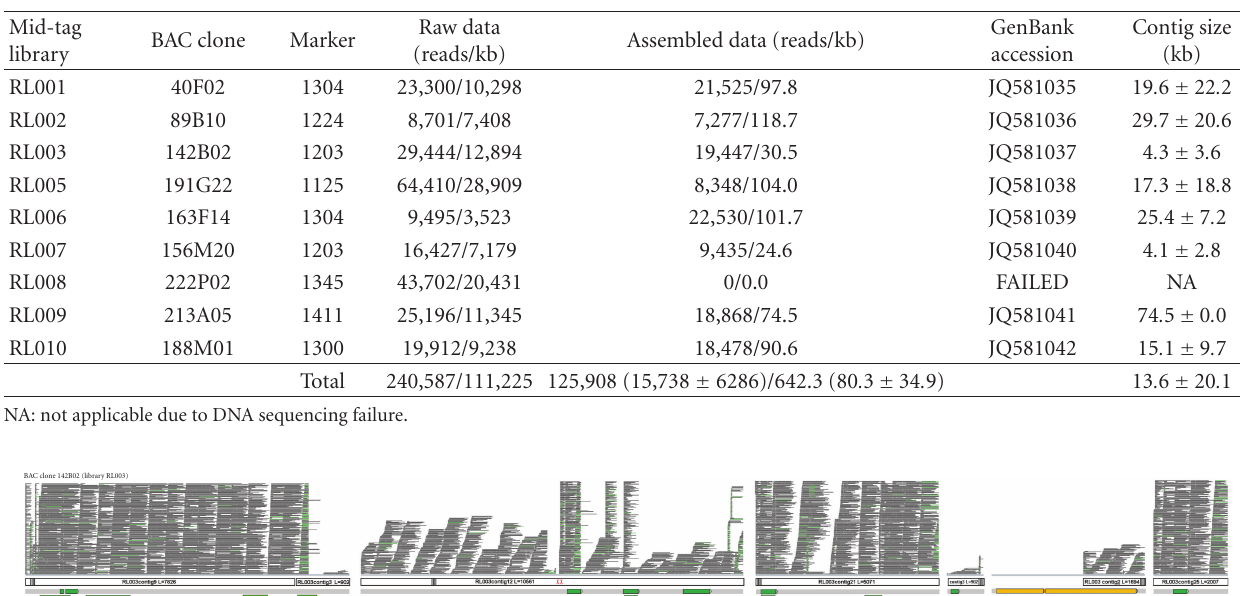
Table 2: Summary of contigs per BAC that were assembled from Roche-454 sequencing data.